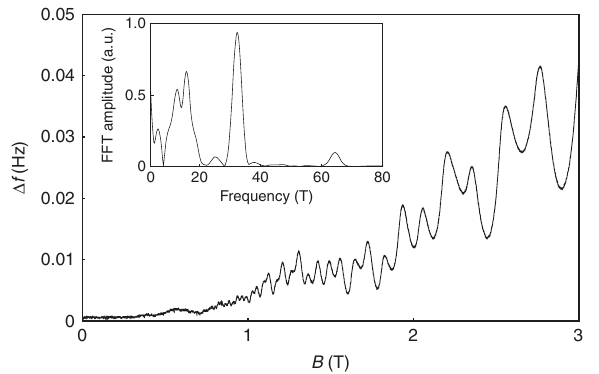
Fig. 3 Quantum oscillations in the Weyl semimetal NbP. At a temperature of 1.2 K, de Haas-van Alphen oscillations of NbP up to 3 T as detected with resonant torsion magnetometry. The inset shows the Fourier spectra. Magnetic fi eld is applied along the crystallographic c axis. The measured noise with the PLL bandwidth of 1 Hz in zero magnetic fi eld is roughly 300 μ Hz anisotropy when only the smallest samples exist in single crystal form.